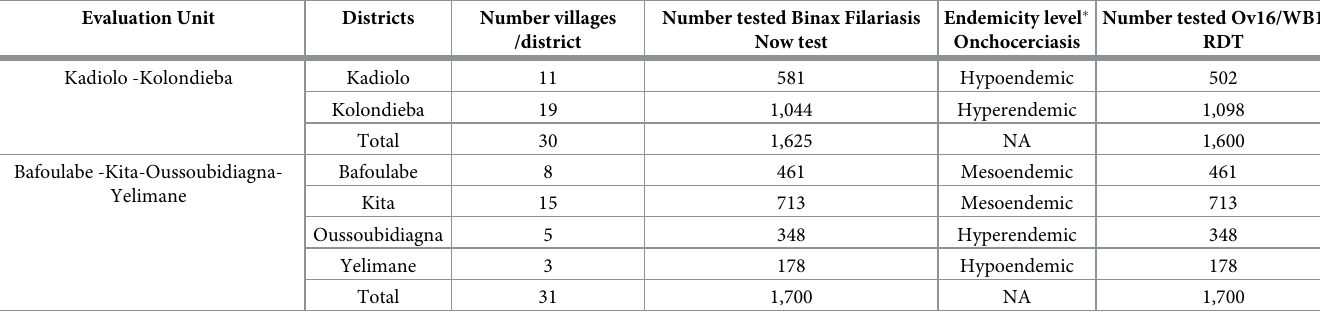
Table 3. Study sites and population